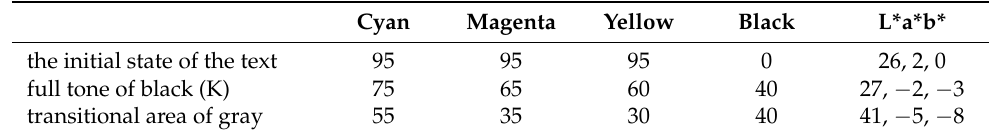
Table 1. Linear graphics in 600 dpi with stochastics, raster elements, black letters and algorithm CMY. (*) asterisk indicates that it is a new color system (derived from the older